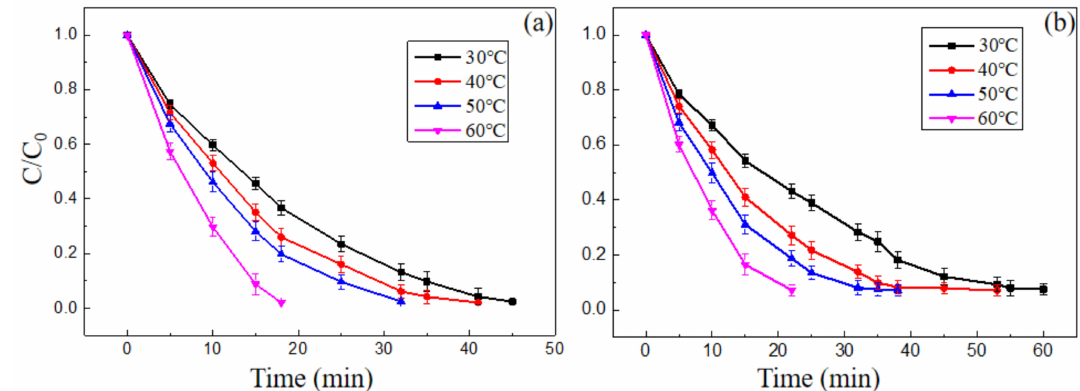
Figure 10. Effect of temperature on the degradation of ( a ) MB and ( b ) MO. Experimental conditions: initial H 2 O 2 concen- tration 18 mM for MB and 23 mM for MO, initial pH value was 3, composite catalyst synthesized with 8 × 10 − 4 mol/L CuCl 2